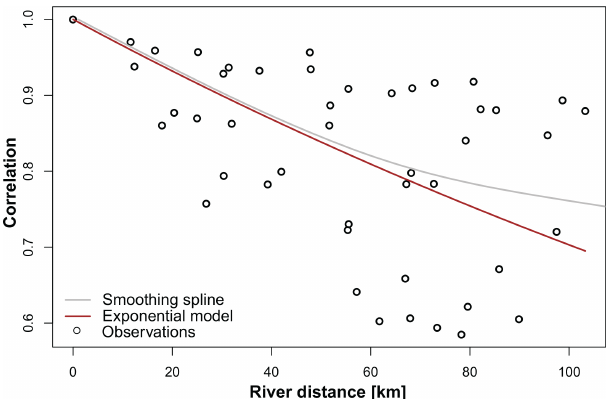
Figure 4. Correlation (entries of the (cid:54) matrix) plotted against river distance. The observations (dots) are given together with a smooth- ing spline (grey line) and an exponential model (brown